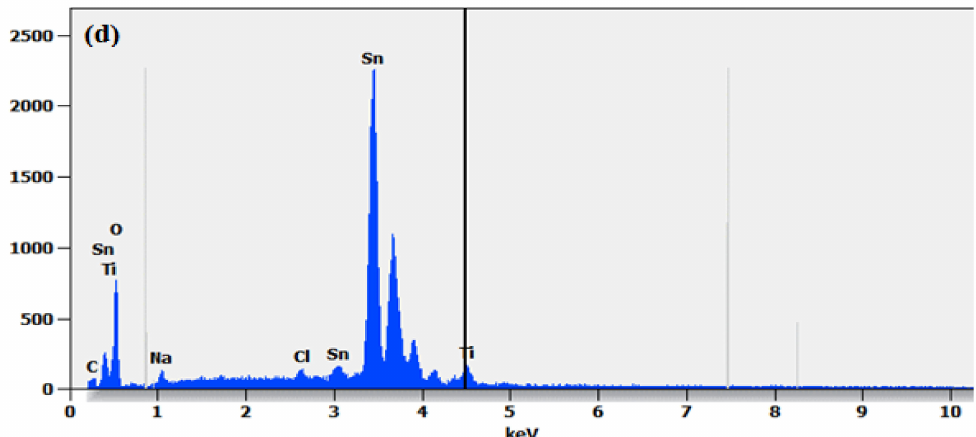
Figure 4. FESEM images of the as-prepared samples: ( a ) Pure SnO 2 , ( b ) SnO 2 : Ti 4%. EDAX spectra of: ( c ) pure SnO 2 NPs, ( d ) SnO 2 : Ti 4%.